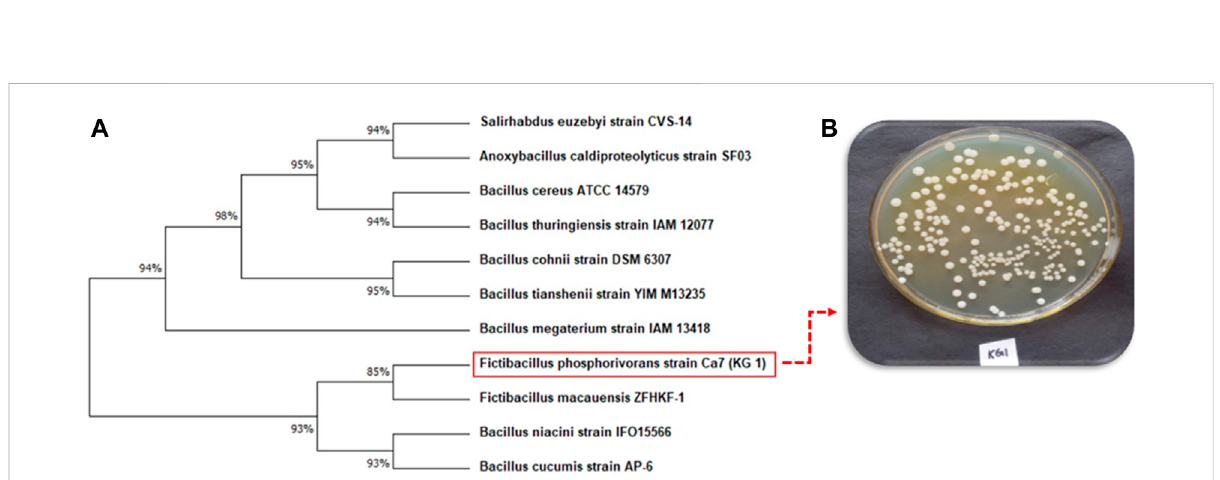
FIGURE 5 Molecular Phylogenetic treeofKG1strain (A) Fictibacillus phosphorivorans withtenotherbacterialstrainand (B) mostdominantbacterialstrain Fictibacillus phosphorivorans isolated from time series study site in the River Ganges at Patna,